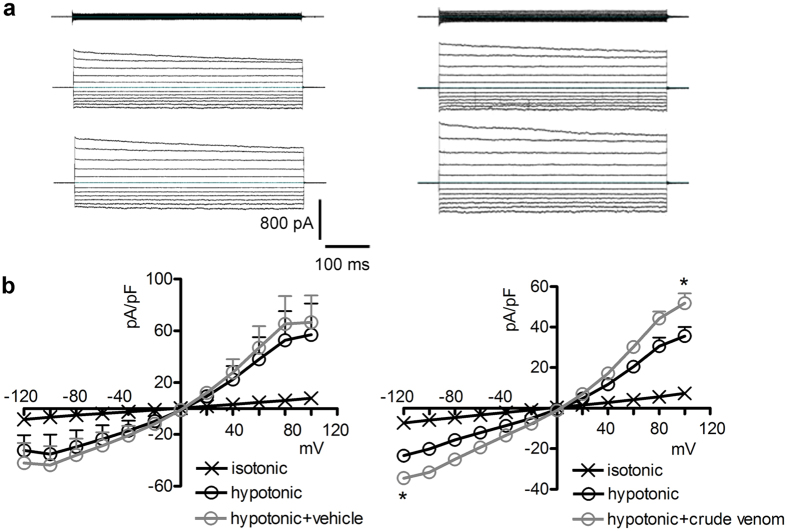
Crude venom does not inhibit IClswell.(a) Original current recordings obtained from HEK 293 Phoenix cells in whole-cell configuration with pipette solution 1 (Table 2) and bath solutions 1 (isotonic, Table 1) – top panels – and 2 (hypotonic, Table 1) – middle and lower panels – before and after addition of the vehicle (left panels) or crude venom (right panels) to the hypotonic bath solution. (b) Current density (pA/pF) to voltage (mV) relationship of Cl− currents obtained in isotonic and hypotonic solutions before and after the addition of the vehicle (left; n = 5) or 0.025 μg/μl crude venom (right; n = 4) to the hypotonic solution after complete activation of IClswell (i.e. after a ~20 min exposure to the hypotonic solution). *p < 0.05 compared to hypotonic, paired Student’s t test.